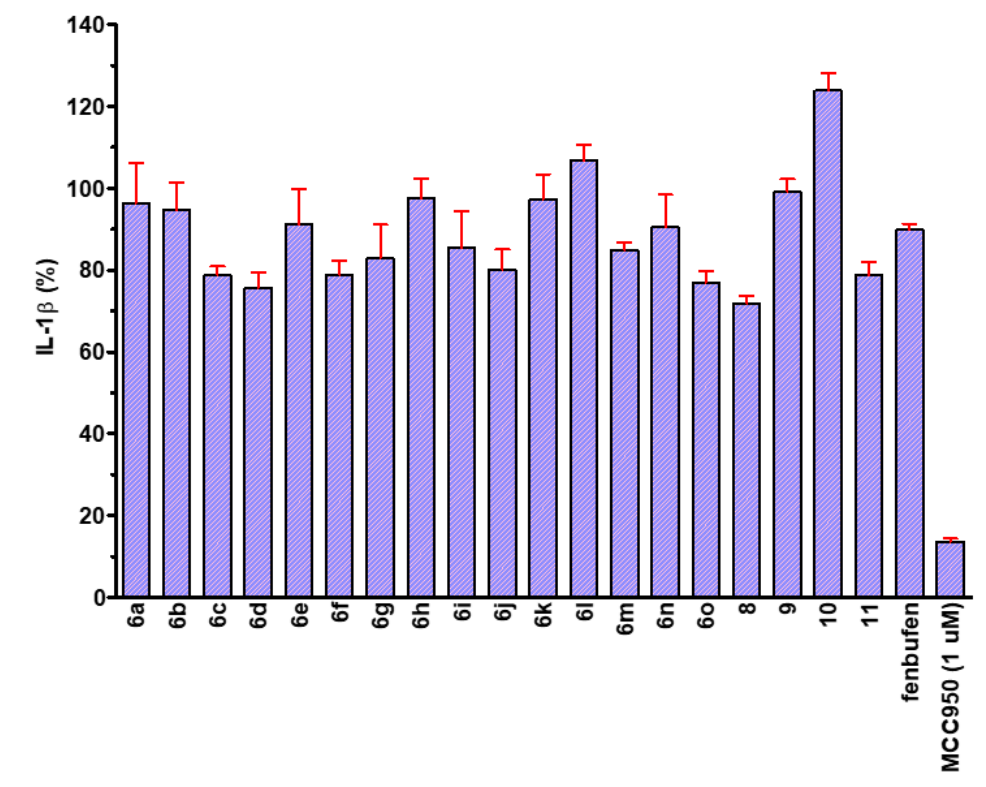
Figure 4. Fenbufen analogs at a concentration of 50 μ M attested for their inhibition against IL1- β release.